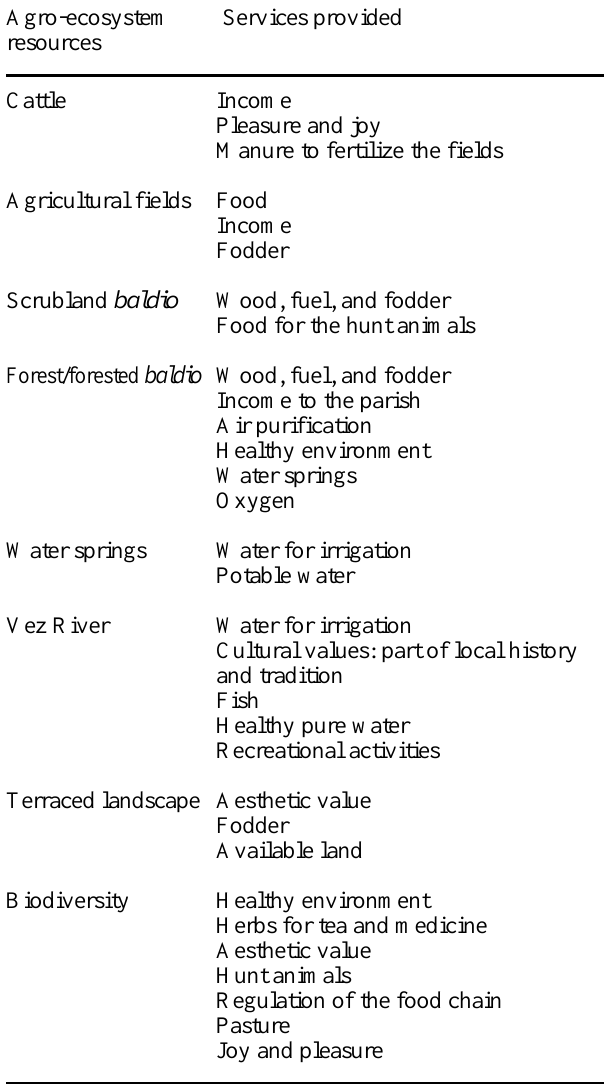
Table 4 . Combined results of agro-ecosystem resources scoring and ranking. Agro-ecosystem resources are listed in decreasing order of